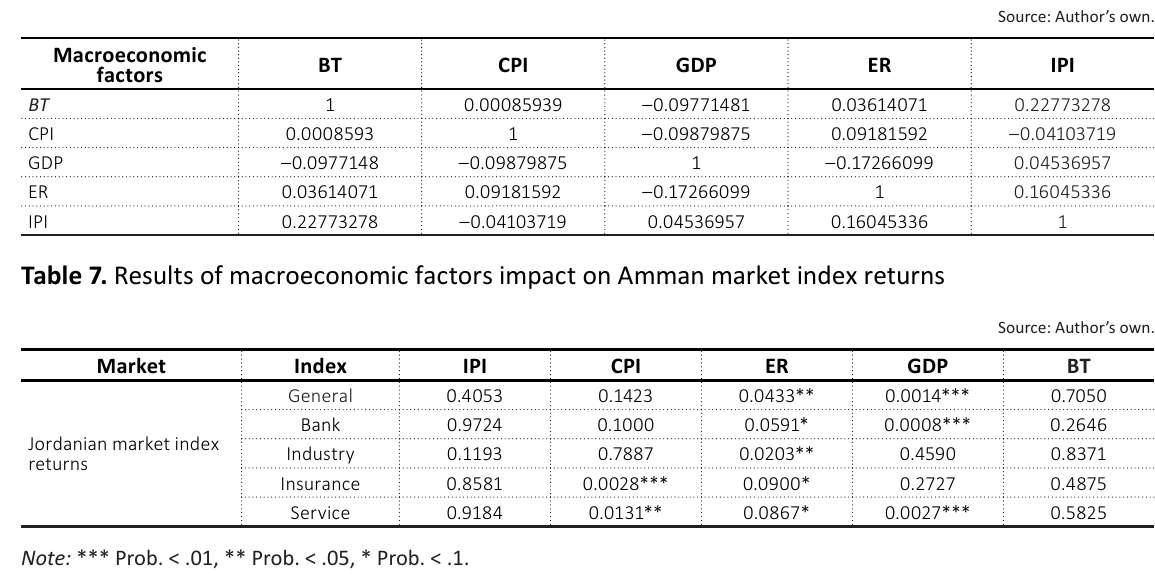
Table 6. The correlation tests results for Jordanian market